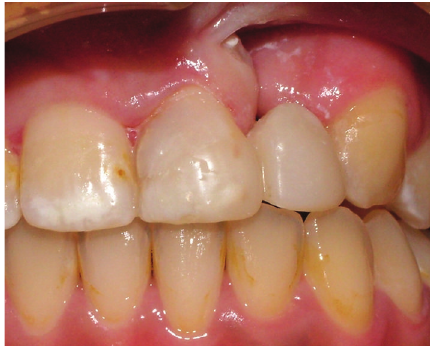
Figure 8: Final restoration.